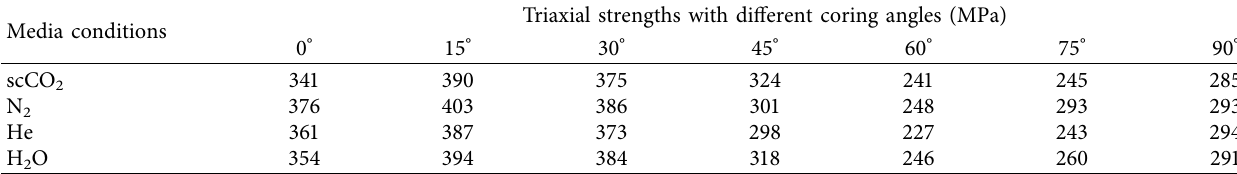
Table 2: Core strength at diferent coring angles with diferent